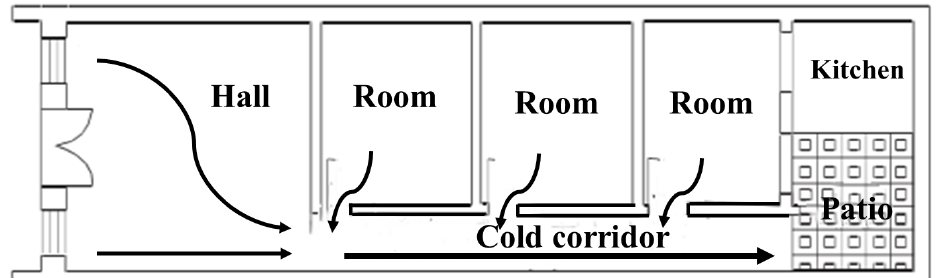
Figure 9. The ventilation design of traditional buildings in Guangdong.